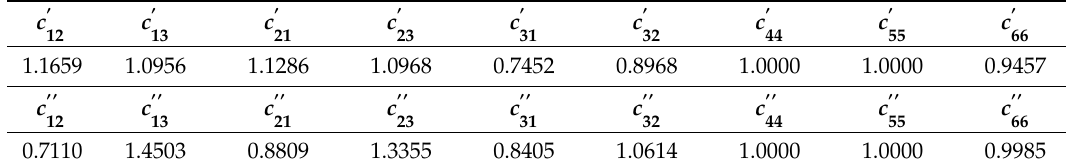
Table 3. Yield 2004-18p coe ffi cients for AA 2008-T4 sheet.